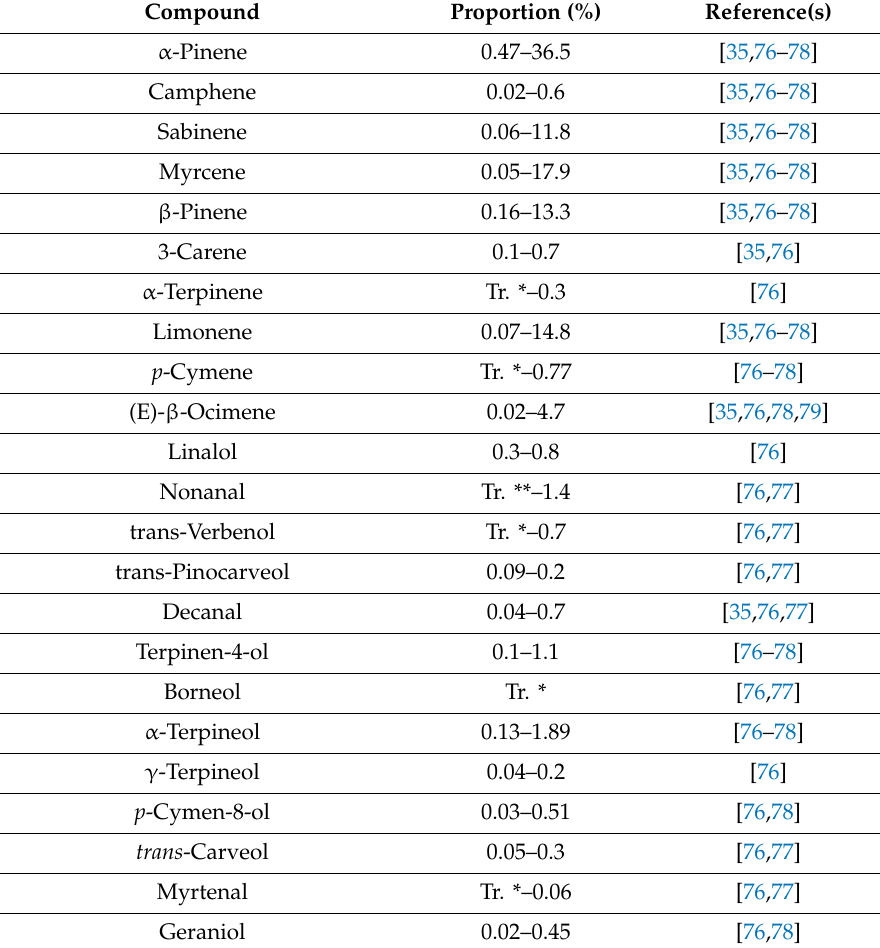
Table 2. Detailed composition of the essential oil obtained from S. virgaurea L. flowering